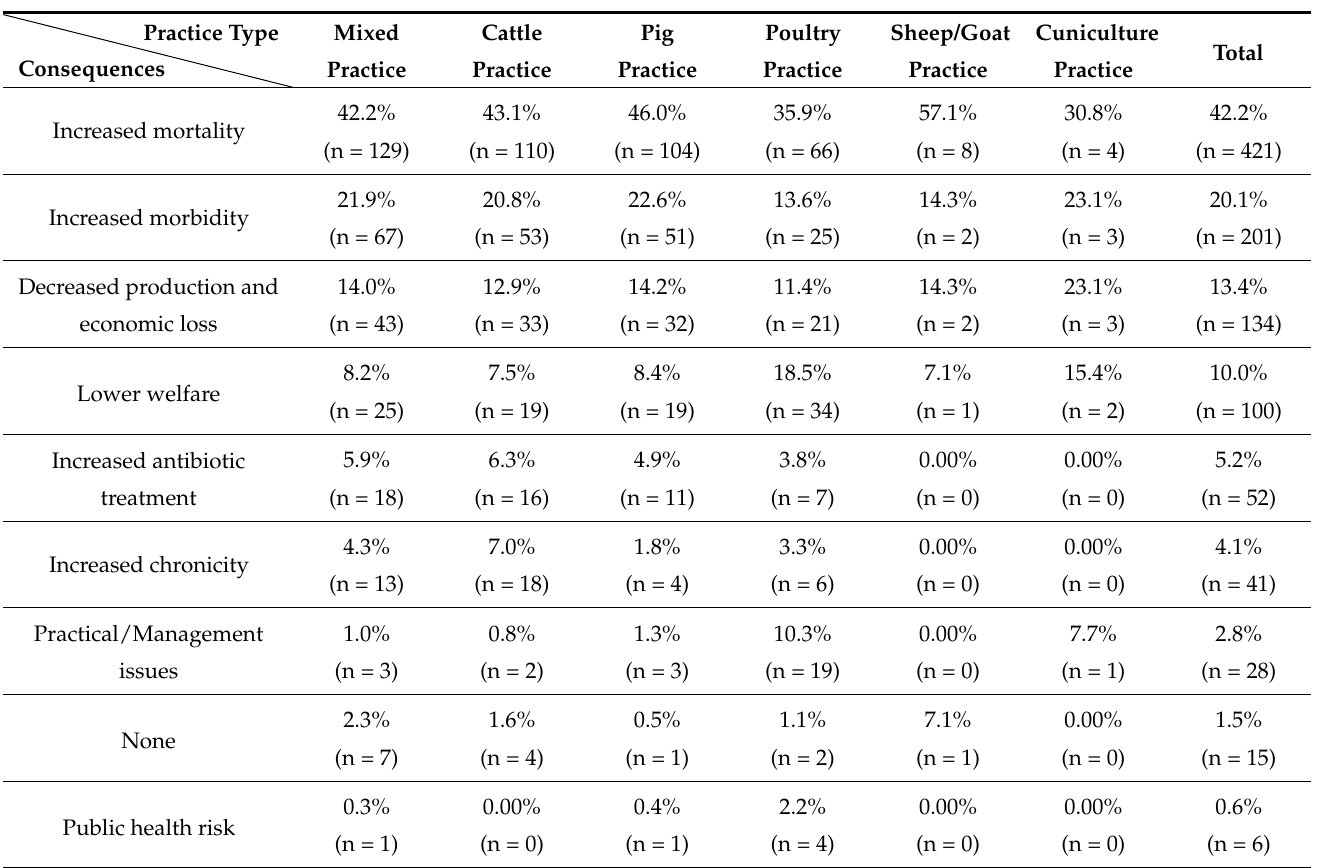
Table 2. Most significant health and welfare consequences for the most frequent model of metaphy- lactic treatment outlined per practice type if metaphylaxis were prohibited (Q8d with 998 responses, multiple answer